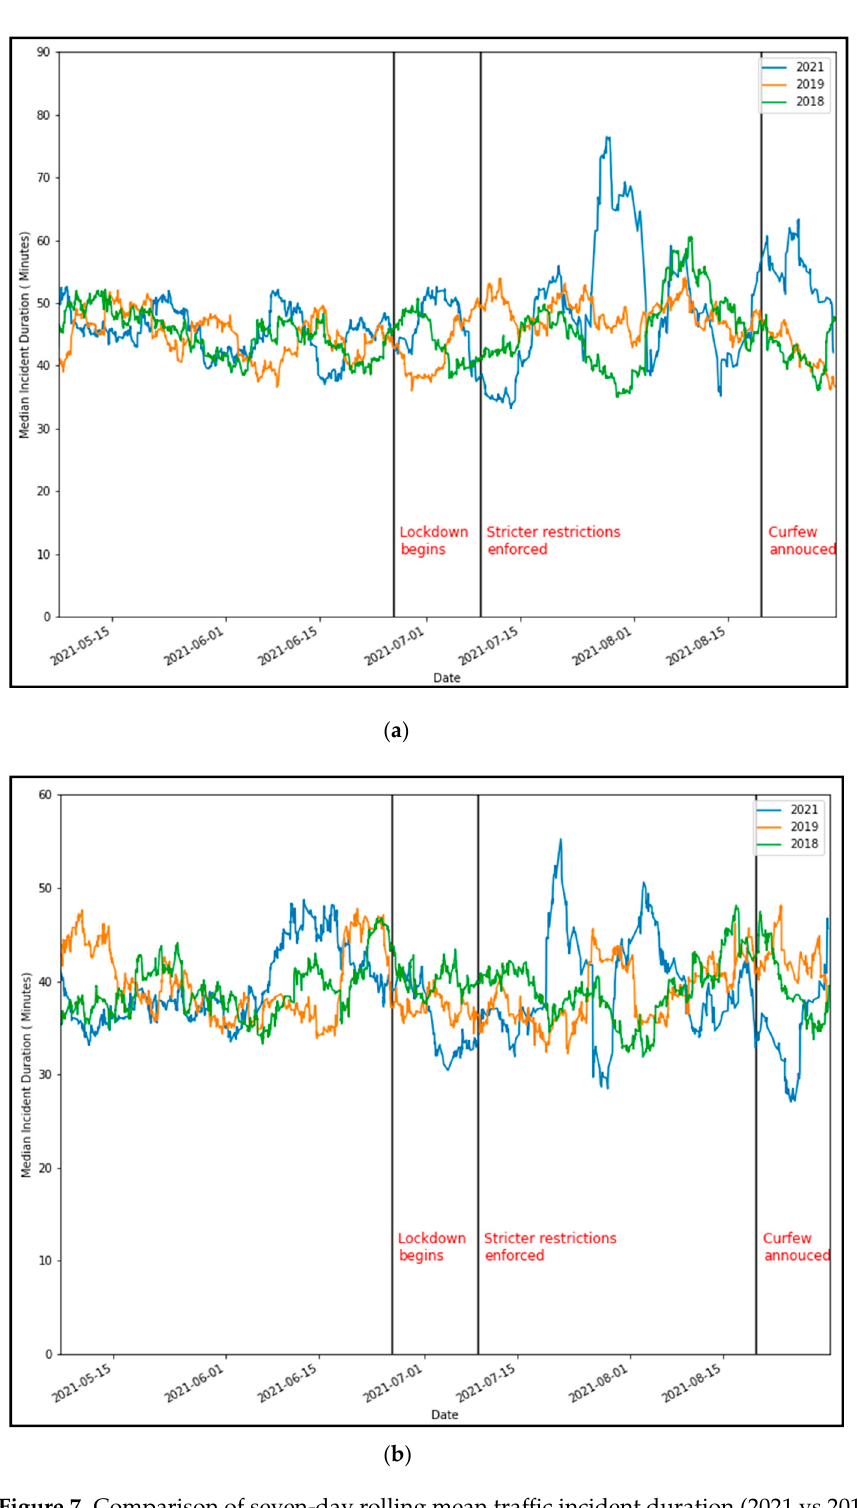
Figure 7. Comparison of seven-day rolling mean traffic incident duration (2021 vs 2018 and 2019). ( a ) Crash duration and ( b ) breakdown duration.